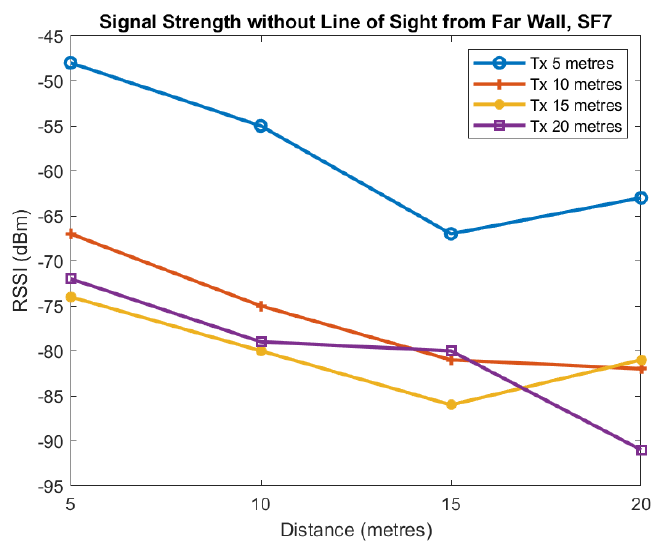
Figure 19. RSSI against receiver distance from junction for different transmitter distances from junction, Far-Wall,